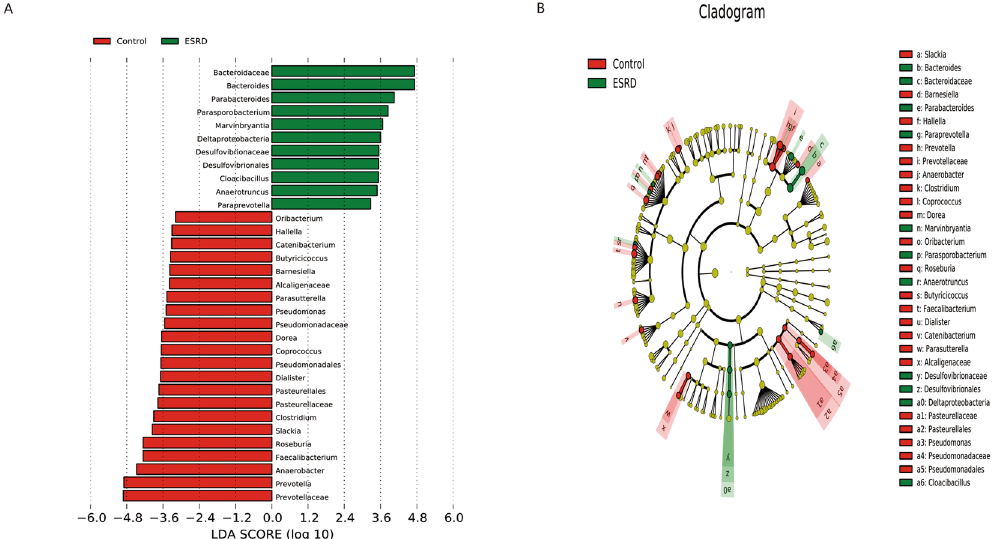
Figure 3. Indicator microbial groups within the three groups of individuals with logarithmic linear discriminant analysis (LDA) score higher than 2 determined by effect size (LefSe). ( A ) Histogram of the LDA scores computed for differentially abundant bacterial taxa between healthy controls and patients with ESRD. ( B ) Cladograms of bacterial lineages with significantly different representation in humans with or without ESRD. Lineages on the bacterial trees are color-coded to indicate whether the taxon does (red or green) or does not (yellow) significantly differ between sample classes. Of those, 11 bacterial taxa were significantly overrepresented in samples from ESRD (green) and 22 bacterial taxa were overrepresented in samples from healthy control (red). Prevotella (red) were significantly overrepresented in control and Bacteroides (green) were overrepresented in ESRD patients. The producing butyrate bacterial taxa (Roseburia, Faecalibacterium, Prevotellaceae, Prevotella, and Coprococcus) was under-abundant in ESRD